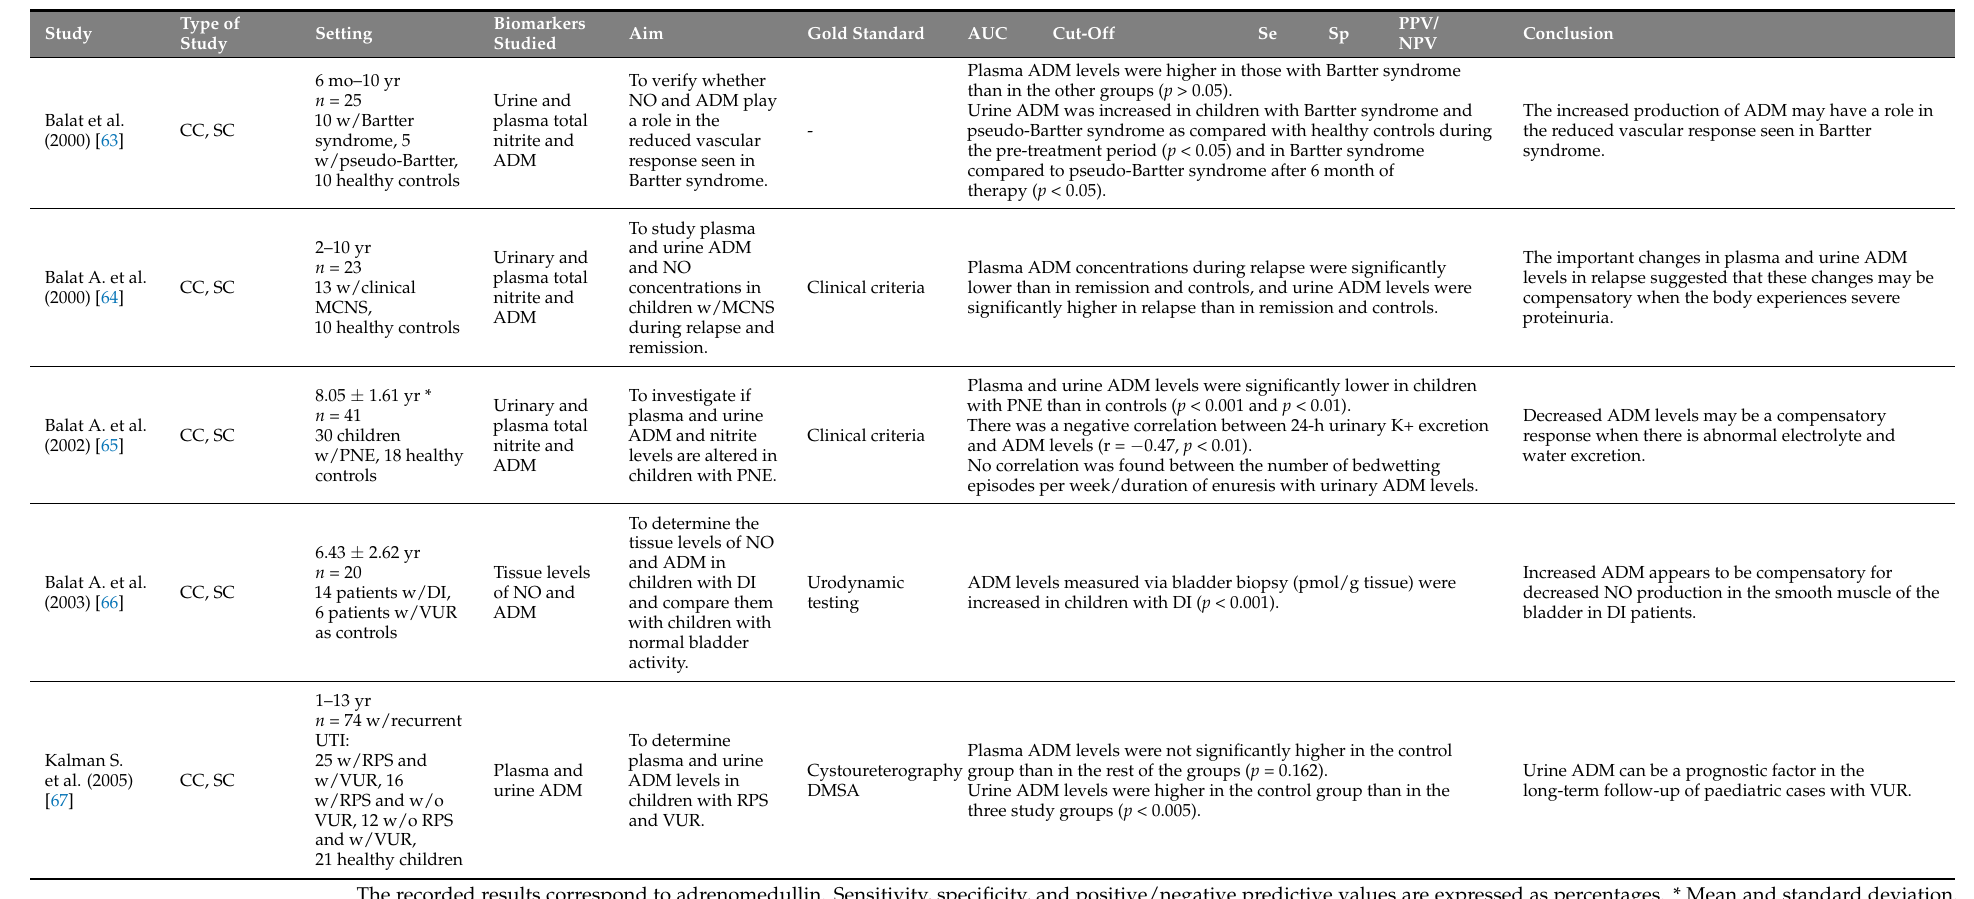
Table 4. Adrenomedullin in nephro-urological